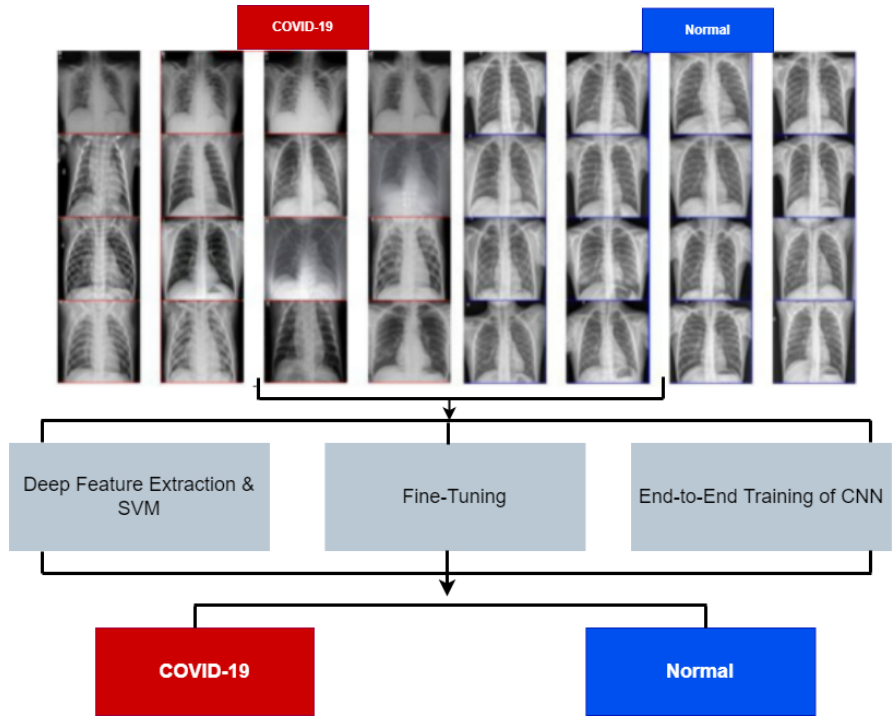
Figure 2. Deep learning model for COVID-19 detection